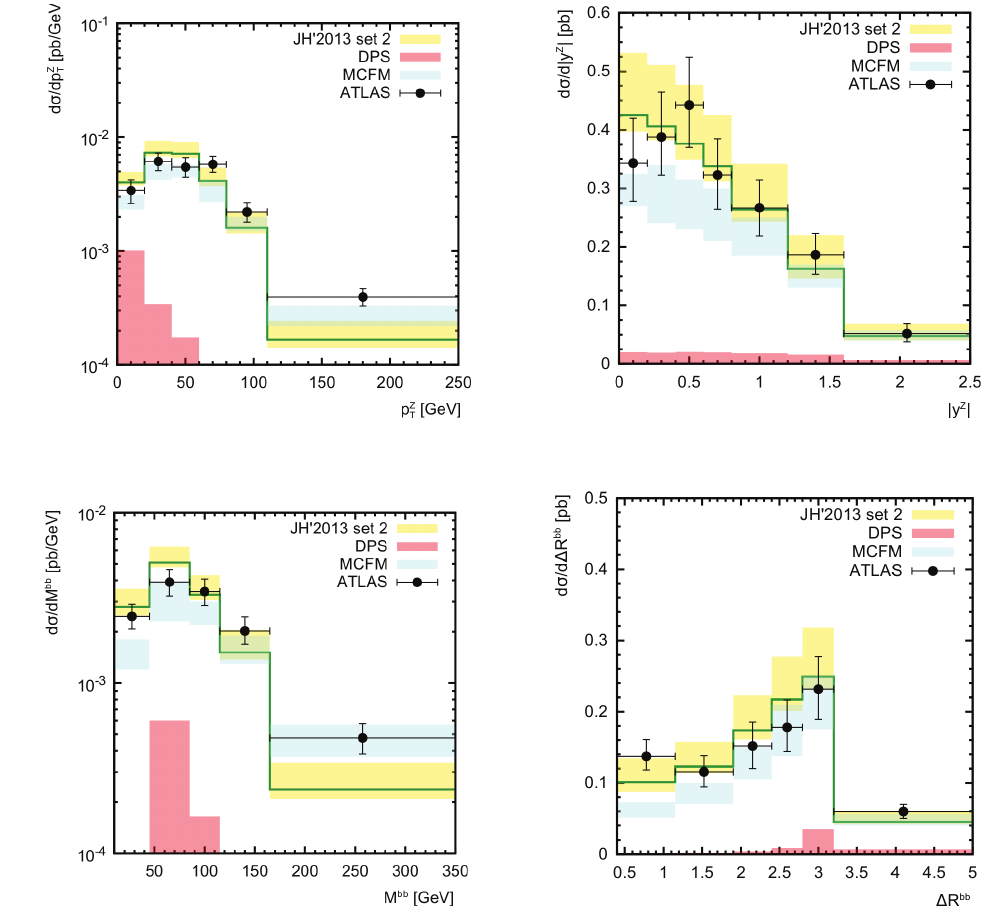
Figure 3. Associated production of a Z boson with two beauty jets at √ s = 7 TeV calculated as a function of the Z boson transverse momentum, rapidity, invariant mass of the b -jet pair and angular separation between the jets. Notation of the histograms is the same as in Fig. 1. The data are from ATLAS [3]. The MCFM [28] predictions are taken from